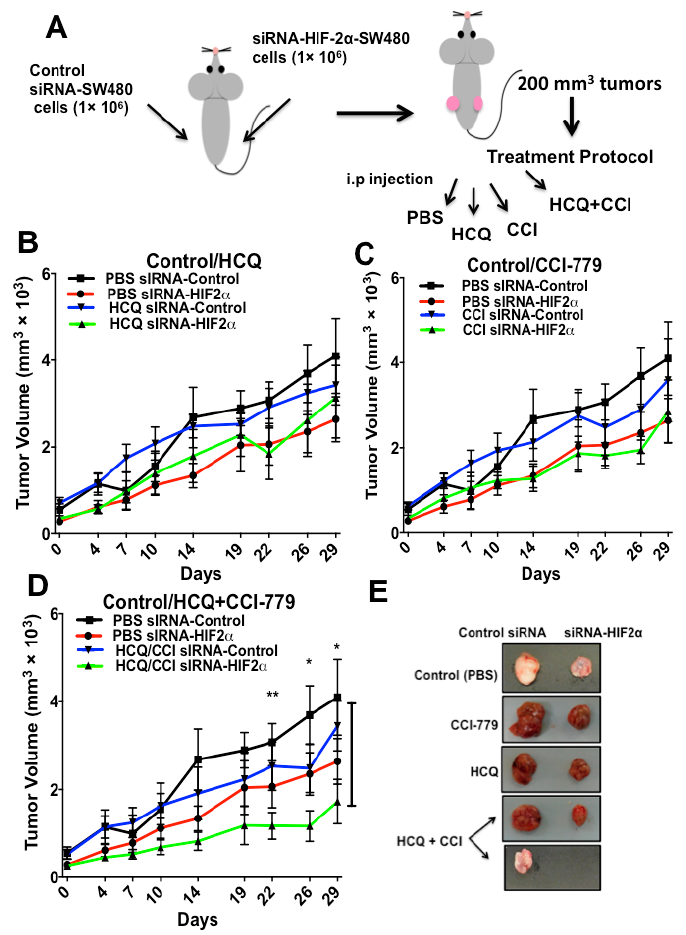
Figure 5. Resistance to drugs can be overcome through coordinate HIF-2 α depletion with autophagy inhibition and drug treatment in vivo using a mouse xenograft model. ( A ) Six-week-old male nude mice were s.c. injected at their left flanks with 1 × 10 6 SW480 cells stably expressing the control siRNA plasmid, and in the same animals, at their right flanks, with 1 × 10 6 SW480 HIF-2 α -silenced cells. Once tumors reached around 200 mm 3 , mice were randomly segregated into four groups (5 mice per group and two xenograft tumors per mouse) and began treatment: they received i.p injection of phosphate-buffered saline (PBS, control), or HCQ (65 mg/kg), or CCI-779 (0.5 mg/kg) or the combination of CCI-779 and HCQ, respectively. ( B–D ) Tumor growth curves were obtained by measuring the tumor volumes at the indicated time points. Each data point represents the mean ± SEM tumor volume from 5 mice in each condition. * p = 0.05; ** p = 0.01 ( t -test) compared with vehicle (PBS) control. ( E ) Photographs of the representative tumors obtained in each experimental condition tested.